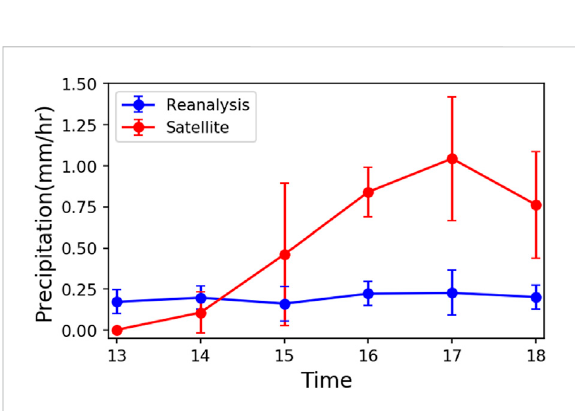
FIGURE 12 Comparison of spatial average precipitaion over 1-h air- moving in fl uence area between reanalysis and satellite